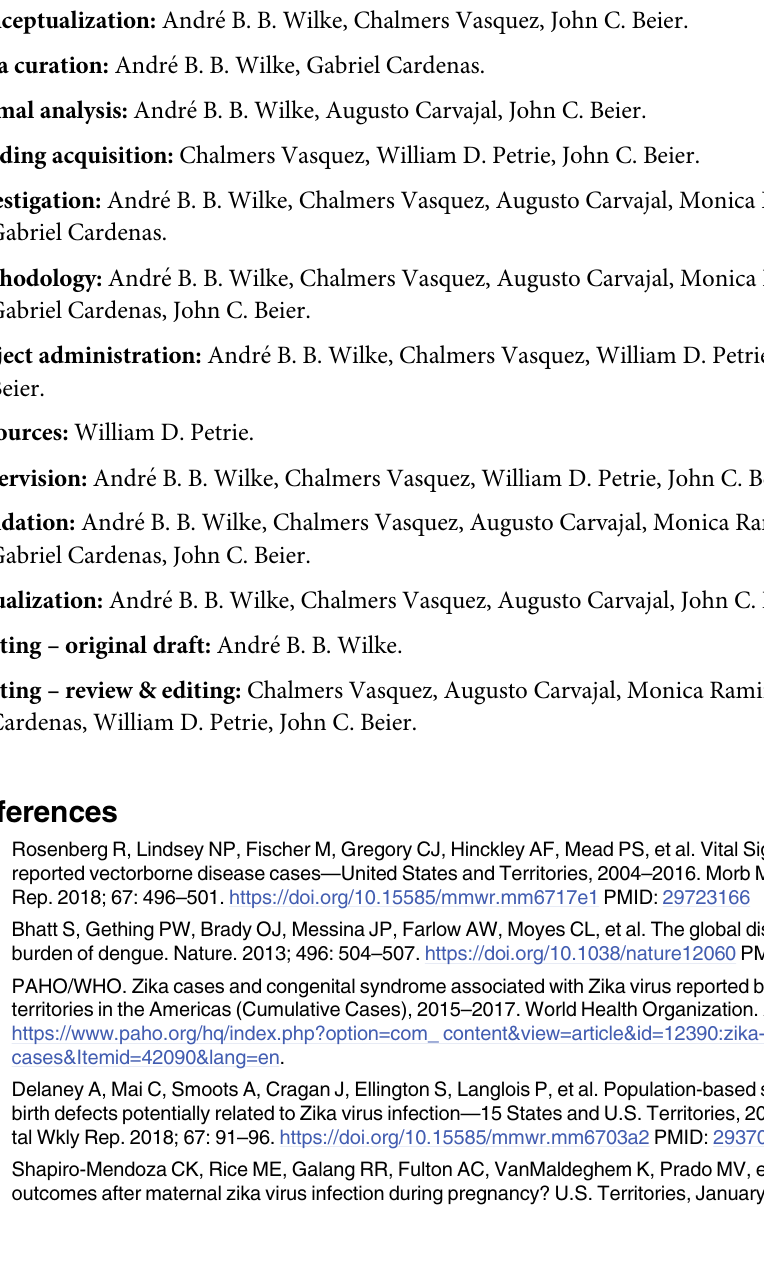
S2 Table. Climate variation in Miami-Dade County, Florida from September to